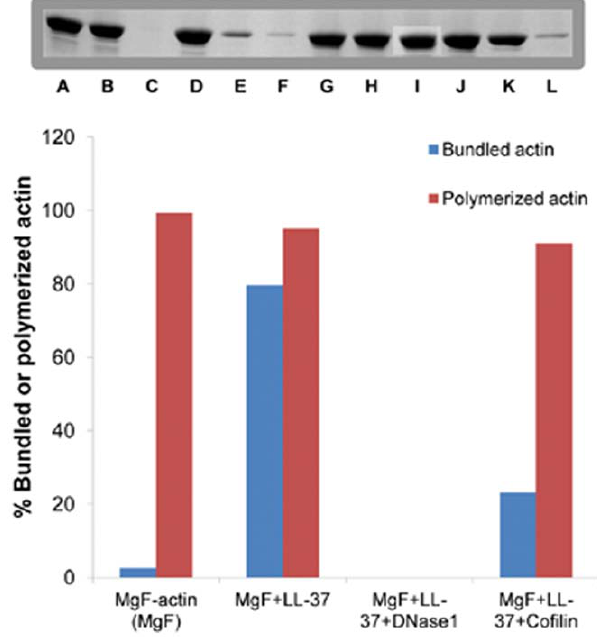
Figure 9. Mechanism of dissociation of LL-37-induced Mg-F- actin bundles by DNase1 and cofilin. LL-37 (9 m M) was added to 2 m M Mg-F-actin. Following a 10 minute incubation, 6 m M DNase1 or 9 m M cofilin were added. After 30 min incubation the samples were divided into two pools and centrifuged at 20,800 6 g or 352,271 6 g for 8 and 60 min, respectively. The supernatants were analyzed by SDS-PAGE and densitometry. Monomer (G-actin) separated from actin filaments (F- actin) by one hour 352,271 6 g centrifugation. Bundled F-actin was separated from unbundled F-actin by low speed (20,800 6 g for 8 min) centrifugation. Thus, the three actin forms (G-, unbundled F- and bundled F-actin) were separated from each other by low and high speed centrifugations. Addition of 6 m M DNase1 and 9 m M cofilin to 4 m M Mg-F-actin (bundled by 9 m M LL-37) promoted disappearance of bundles at 100% and 73%, respectively. The presented data are mean and standard deviation of three independent experiments. Gel insert shows representative actin bands: (A) MgF-actin, pre-spin; (B) MgF-actin low speed; (C) MgF-actin high speed centrifugation; (D) MgF-actin, LL- 37 pre-spin; (E) MgF-actin, LL-37 low speed; (F) MgF-actin, LL-37 high speed centrifugation; (G) MgF-actin, LL-37, DNase1 pre-spin; (H) MgF- actin, LL-37, DNase1 low speed; (I) MgF-actin, LL-37, DNase1 high